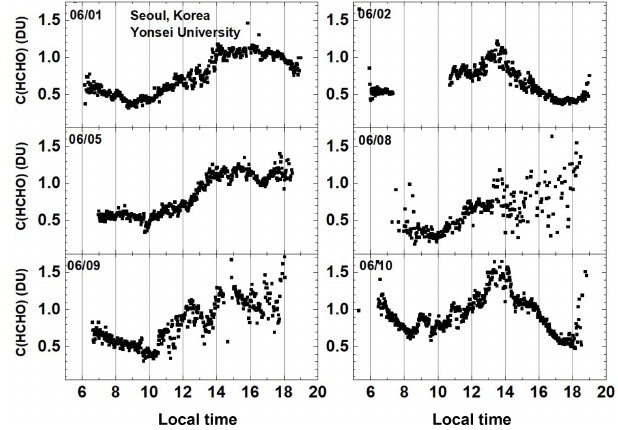
Figure 17. Total column HCHO from Pandora Yonsei University, Seoul for 6 days in June 2016. C(HCHO) on 2 June 2016 has a peak value of 1.2DU at 13:30.